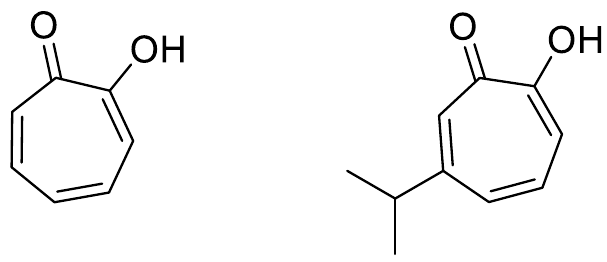
Figure 1. Structures of Tropolone ( left ) and Hinokitiol ( right ).